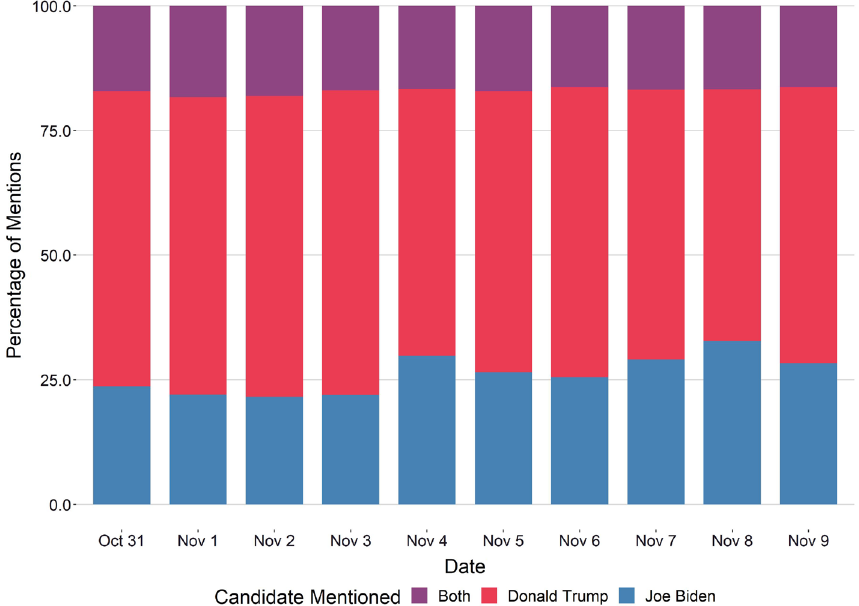
Fig. 1 Percentage share of a presidential candidate mentioned in a tweet per